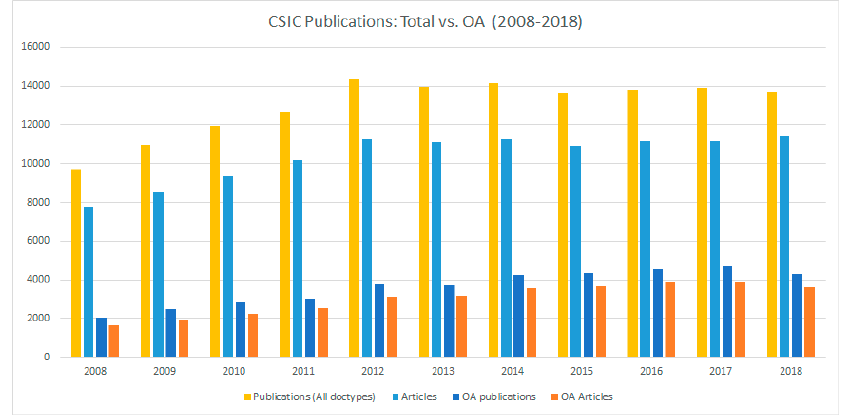
Figure 5. Graph with evolution of Open Access publishing at CSIC between 2008 and 2018.